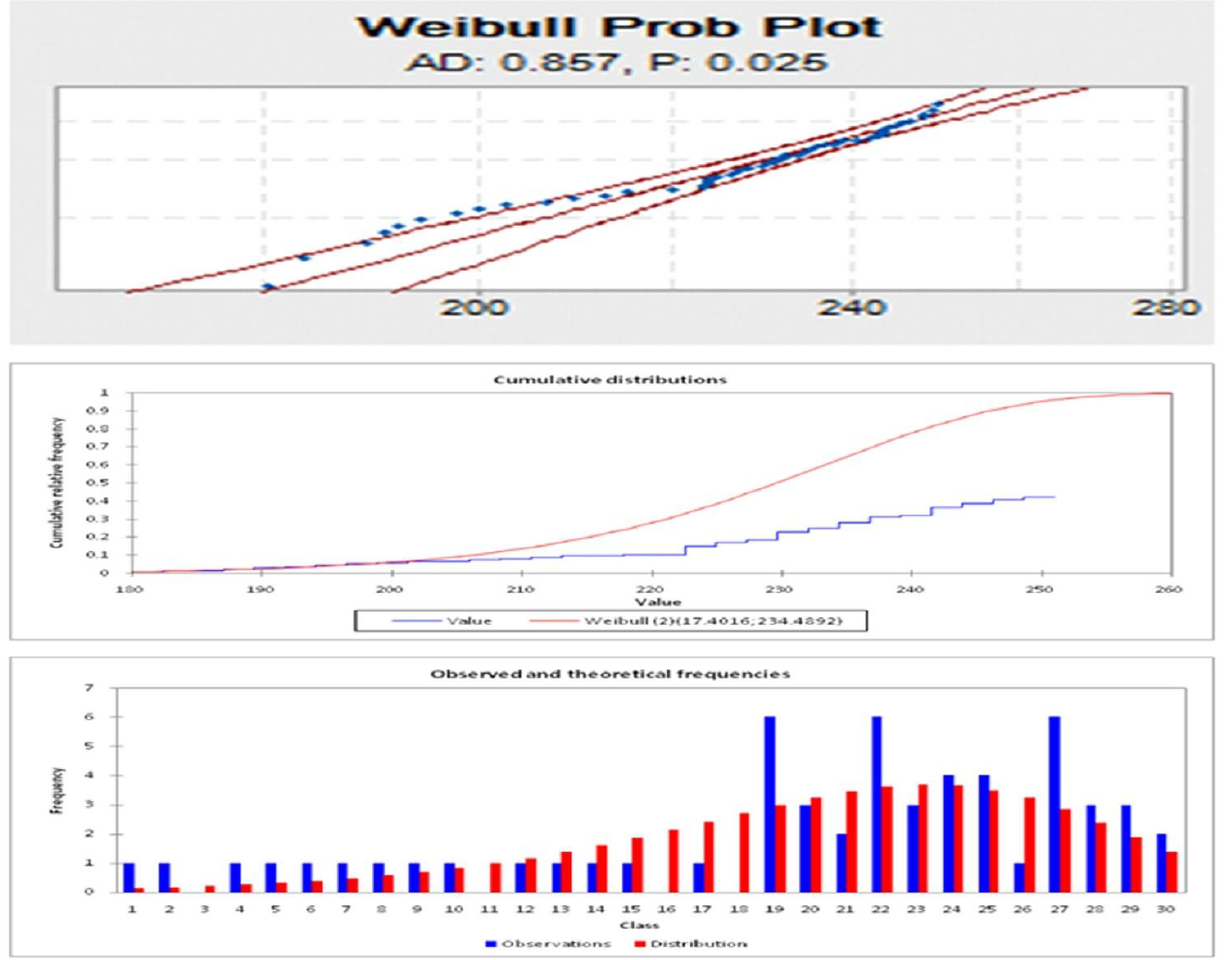
Figure 1: Probability plot showing the degree of distribution fitness (upper graph). Cumulative distribution pattern of both practical and theoretical assumed dispersions (middle graph). best distribution fitting approach showing gap between the typical and actual dispersion pattern (lower